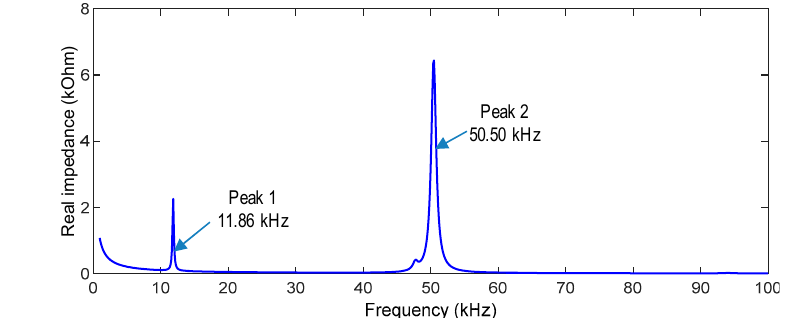
Figure 8. Impedance response of the PZT interface.